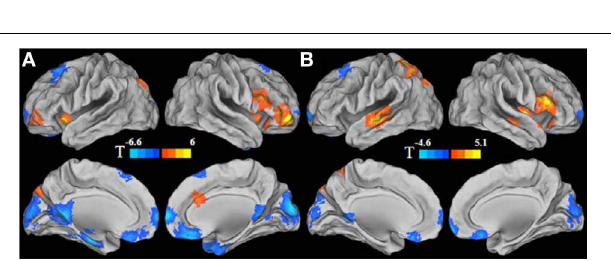
FIGURE A1 | Surface rendering showing the spatial distribution of the long- (A) and short-range (B) FCD in the human brain, which reflect the average number of functional connections per voxel across 289 participants. The images were created using the Computerized Anatomical Reconstruction and Editing Toolkit (CARET) 5.62, which is a free software developed at Washington University (http://brainvis.wustl.edu/wiki/index.php/Caret:About).